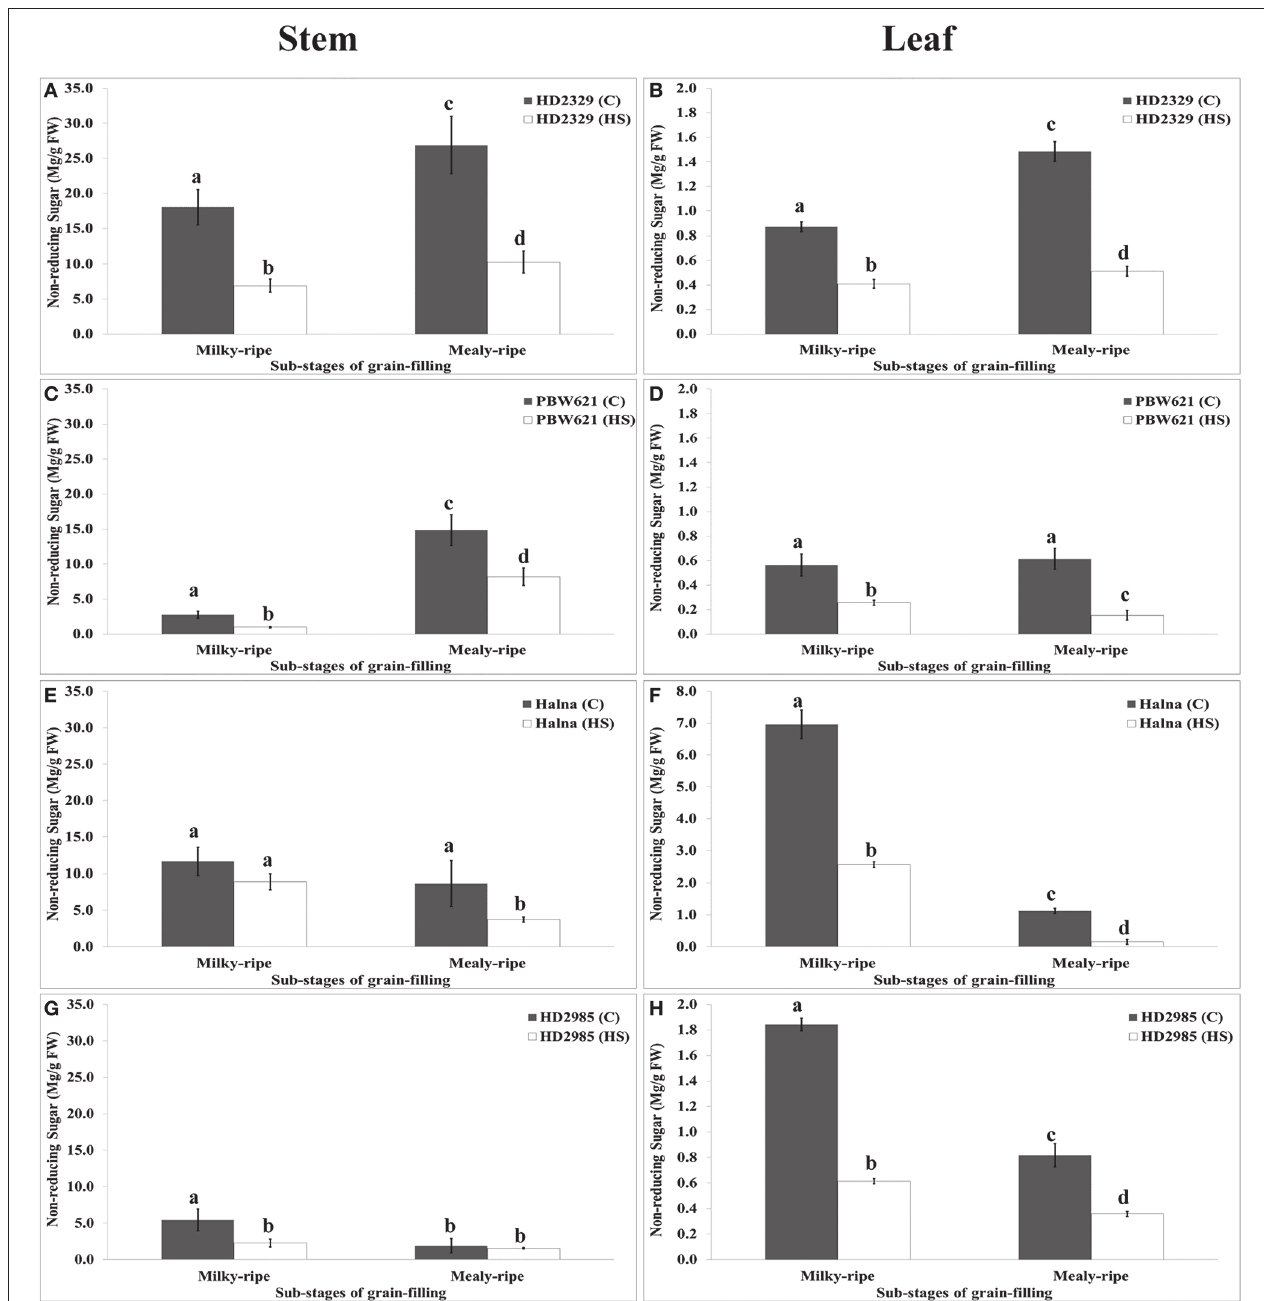
FIGURE 10 | Changes in the non-reducing sugar accumulation in stem and leaves of wheat cvs . under control and heat stress conditions. (A,B) Non-reducing sugar content in stem and leaf of HD2329, (C,D) Non-reducing sugar accumulation in stem and leaf of PBW621, (E,F) Non-reducing sugar content in stem and leaf of Halna, (G,H) Non-reducing sugar accumulation in stem and leaf of HD2985. Thermosusceptible (HD2329 and PBW621) and thermotolerant (Halna and HD2985) were used for the non-reducing sugar accumulation pattern analysis; C − 22 ± 3 ◦ , heat stress –42 ◦ C for 2 h; Milky-ripe and mealy-ripe sub-stages of grain-filling were used for the analysis; different letters above each bar indicate a significant difference ( p < 0.05 ) between the treatments (one-way ANOVA); vertical bars indicate SE ( n = 3 ).